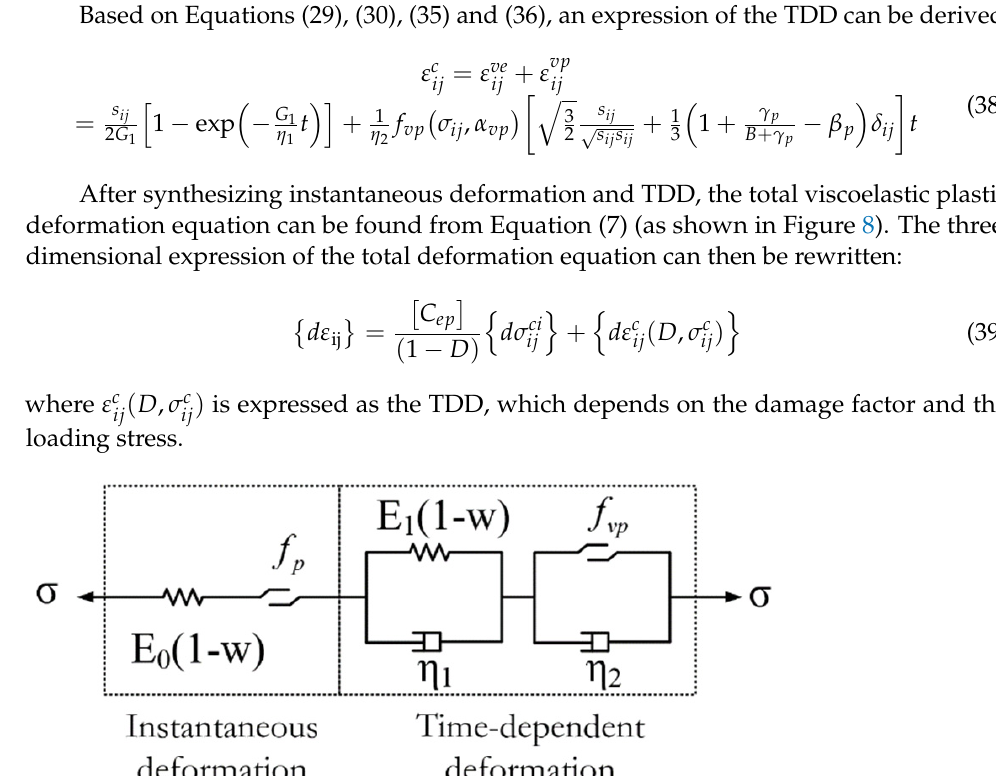
Analytical solution of Nishihara model based on D–P